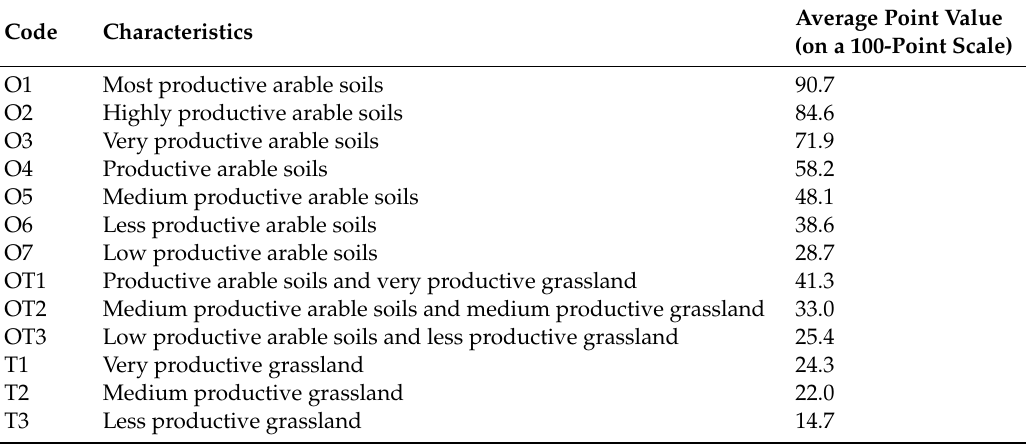
Table 2. Productivity categories of agriculture soils and their point values in Slovakia [18].